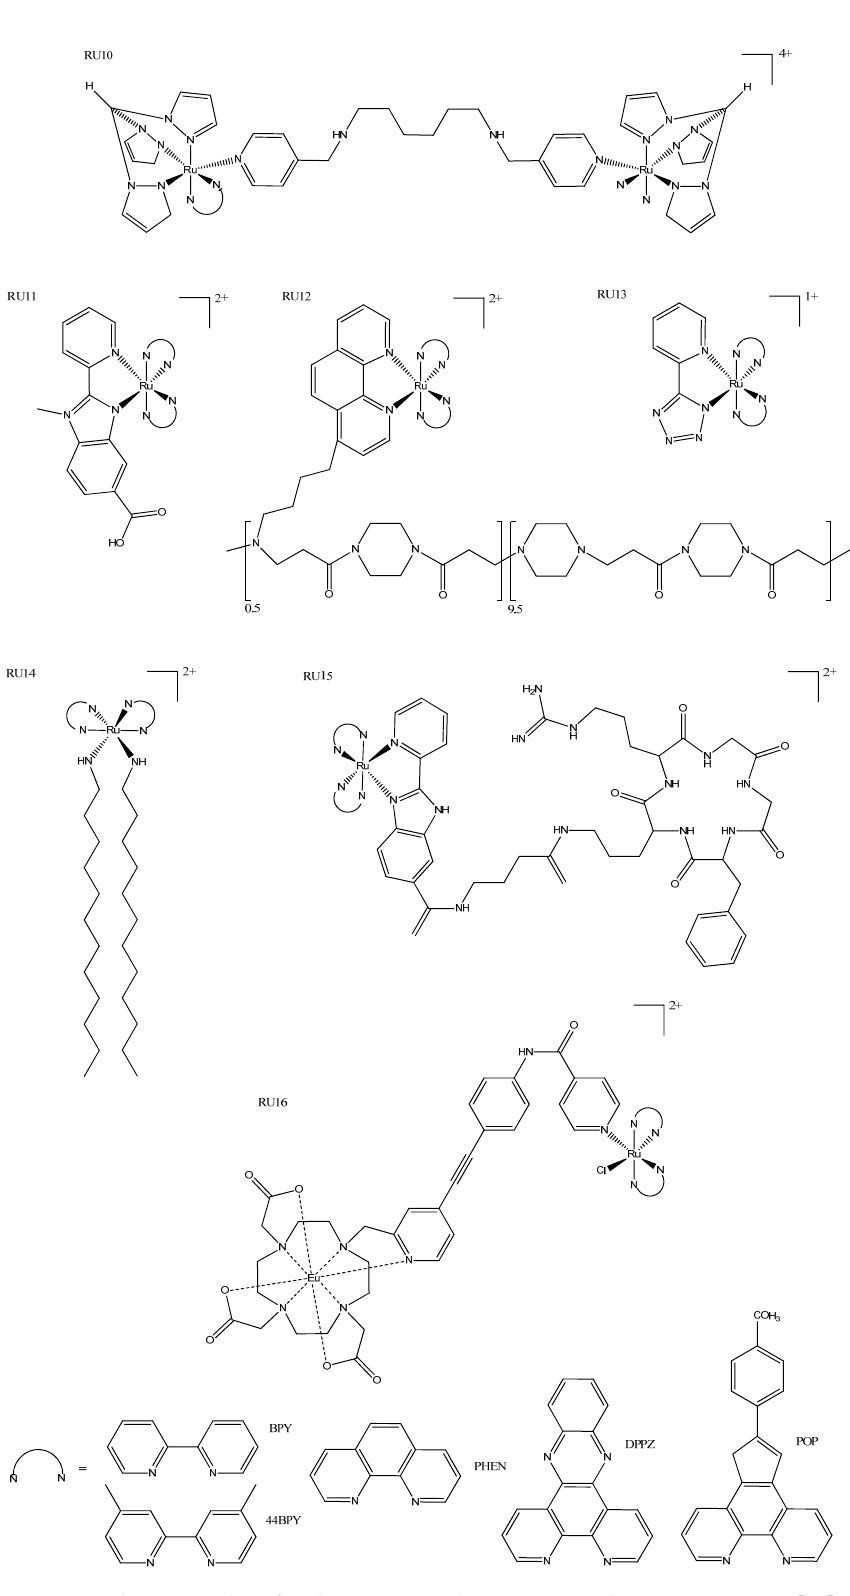
Figure 8. Other examples of ruthenium complexes: RU10, where N^N = DPPZ [62]; RU11, where N^N = BPY [63]; RU12, where N^N = PHEN [64]; RU13, where N^N = BPY [65]; RU14, where N^N = PHEN [66]; RU15, where N^N = POP [67]; and Eu-linked ruthenium complex RU16, where N^N = BPY [68].